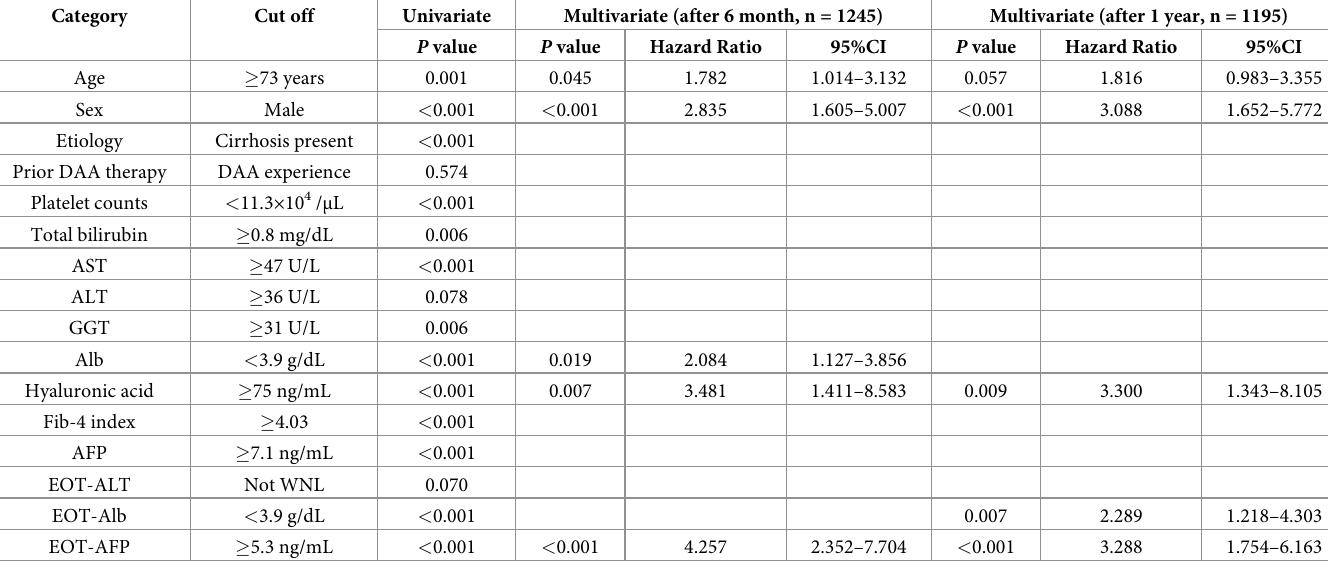
Table 4. Factors associated with the development of hepatocellular carcinoma (HCC) in over 6-month or 1-year follow up